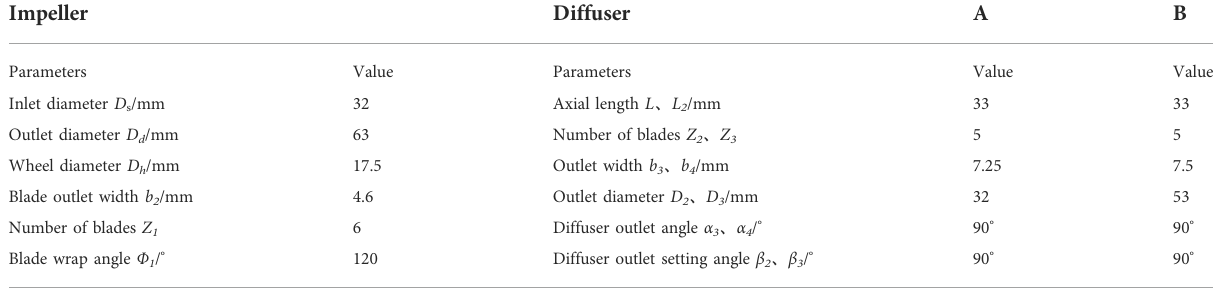
TABLE 1 Main parameters of fl ow-through components of the deep well pump.